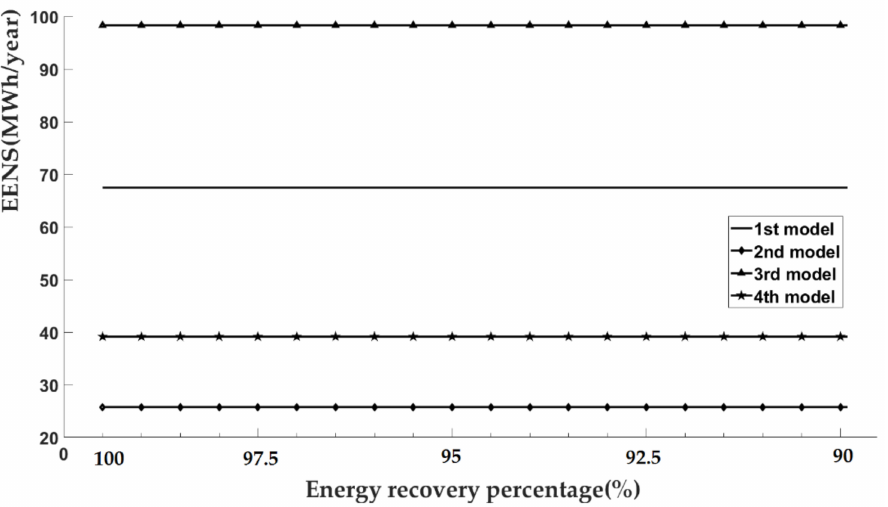
Figure 15. EENS of CLS for all